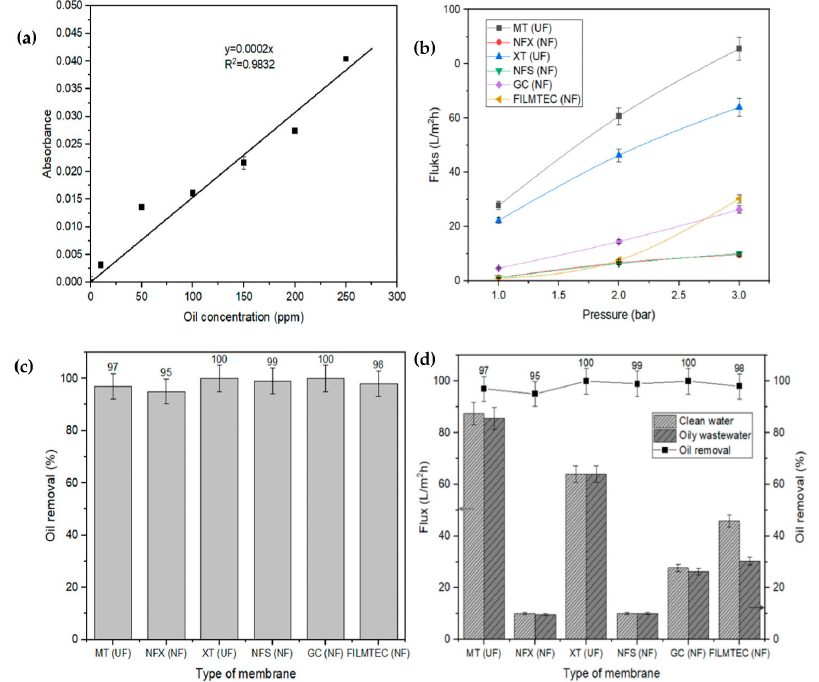
Figure 3. ( a ) Standard curve for oily wastewater analysis. ( b ) The permeate flux response against the applied pressure and the bar chart depicts ( c ) the performance of membranes for oil removal and ( d ) the summary of permeate flux and oil removal percentage of various filtration